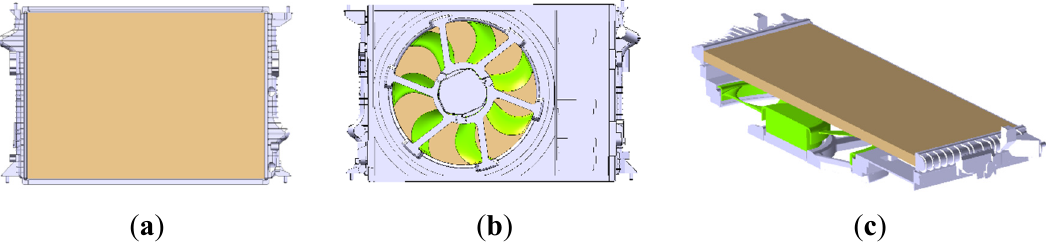
Figure 1. Overview of a cooling module: ( a ) front view, ( b ) rear view, and ( c ) radiator and fan system (cut view).